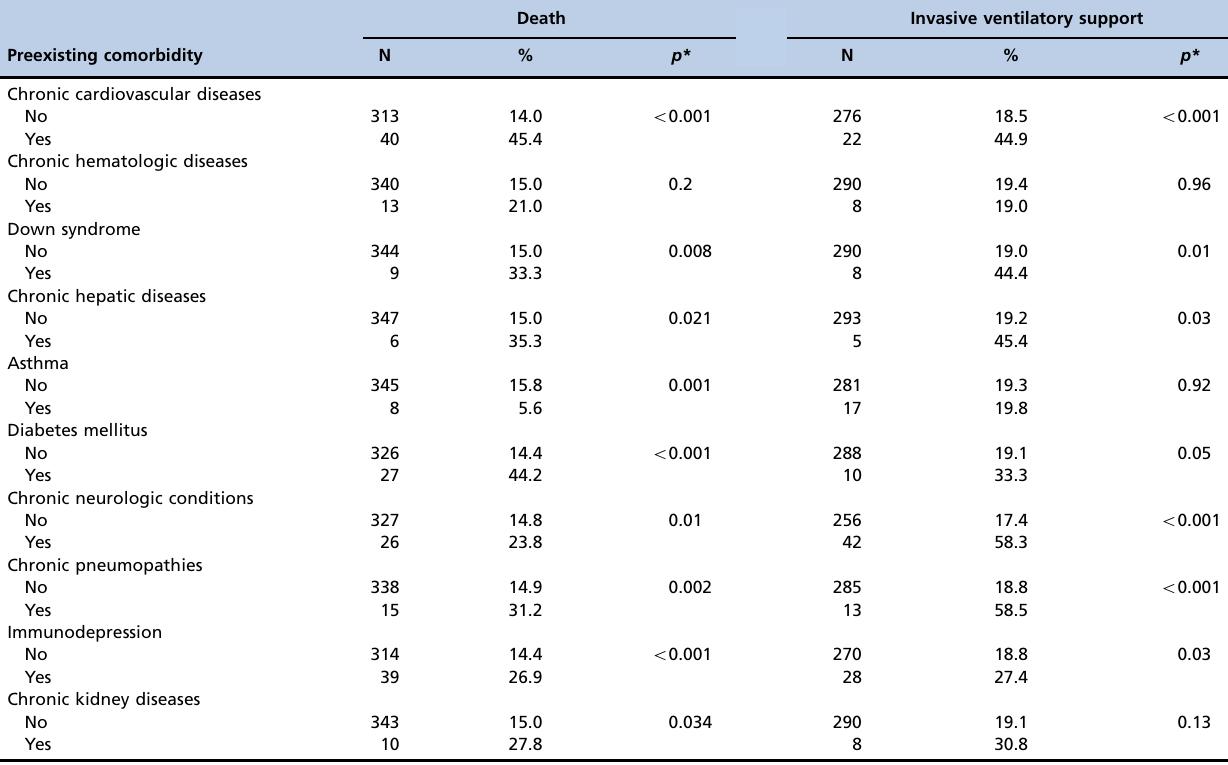
Table 4 - Relationship between preexisting comorbidities and negative outcomes in severe acute respiratory infection caused by SARS- CoV-2 (N=986). Death Invasive ventilatory support Preexisting